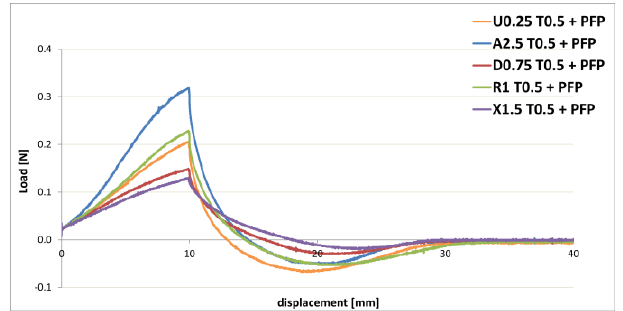
Figure 4. Texture curves obtained from an immersion/de-immersion test performed on the gel formulations containing 2% w / w of PFP: comparison between the samples U0.25T0.5 prepared with U at 0.25% w / w and T at 0.5%, A2.5T0.5 prepared with A at 2.5% w / w and T at 0.5% w / w , D0.75T0.5 prepared with D at 0.75% w / w and T at 0.5% w / w , R1T0.5 prepared with R at 1% w / w and T at